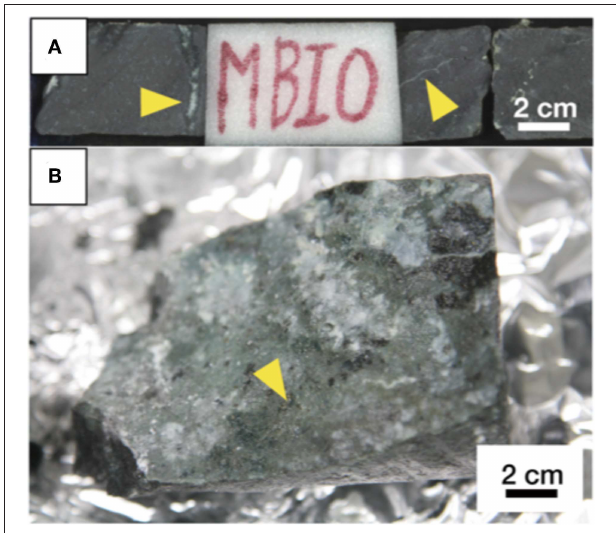
FIGURE 1 | Pictures of a basaltic core sample (U1365E-7R2). (A) A whole-round core including the sampling interval as labeled with MBIO. White fractures/veins pointed out by yellow arrows are filled with calcite. (B) Fracture surface after opening. A yellow arrow indicates the presence of pyrite